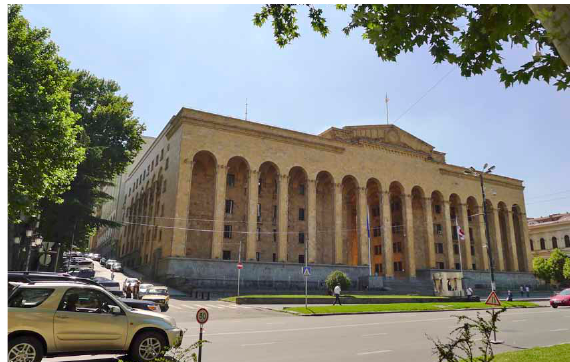
fig. 11. former palace of the Georgian SSr Supreme Council.